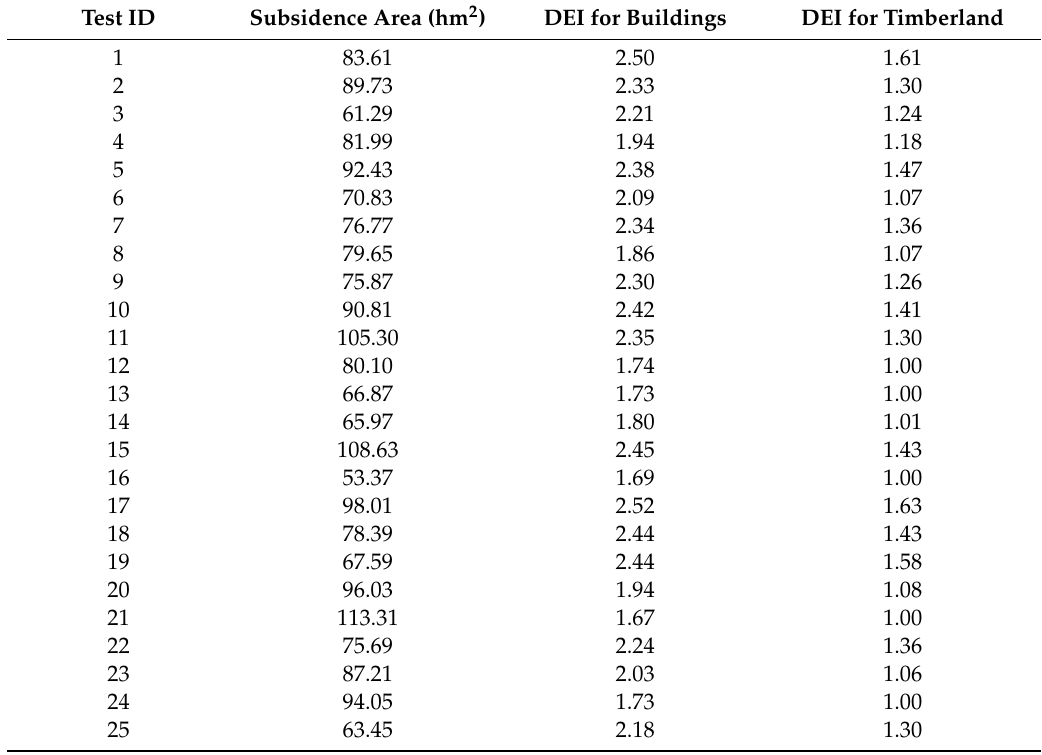
Table 7. Subsidence areas and global ground damage extent indexes (DEI) of the simulation